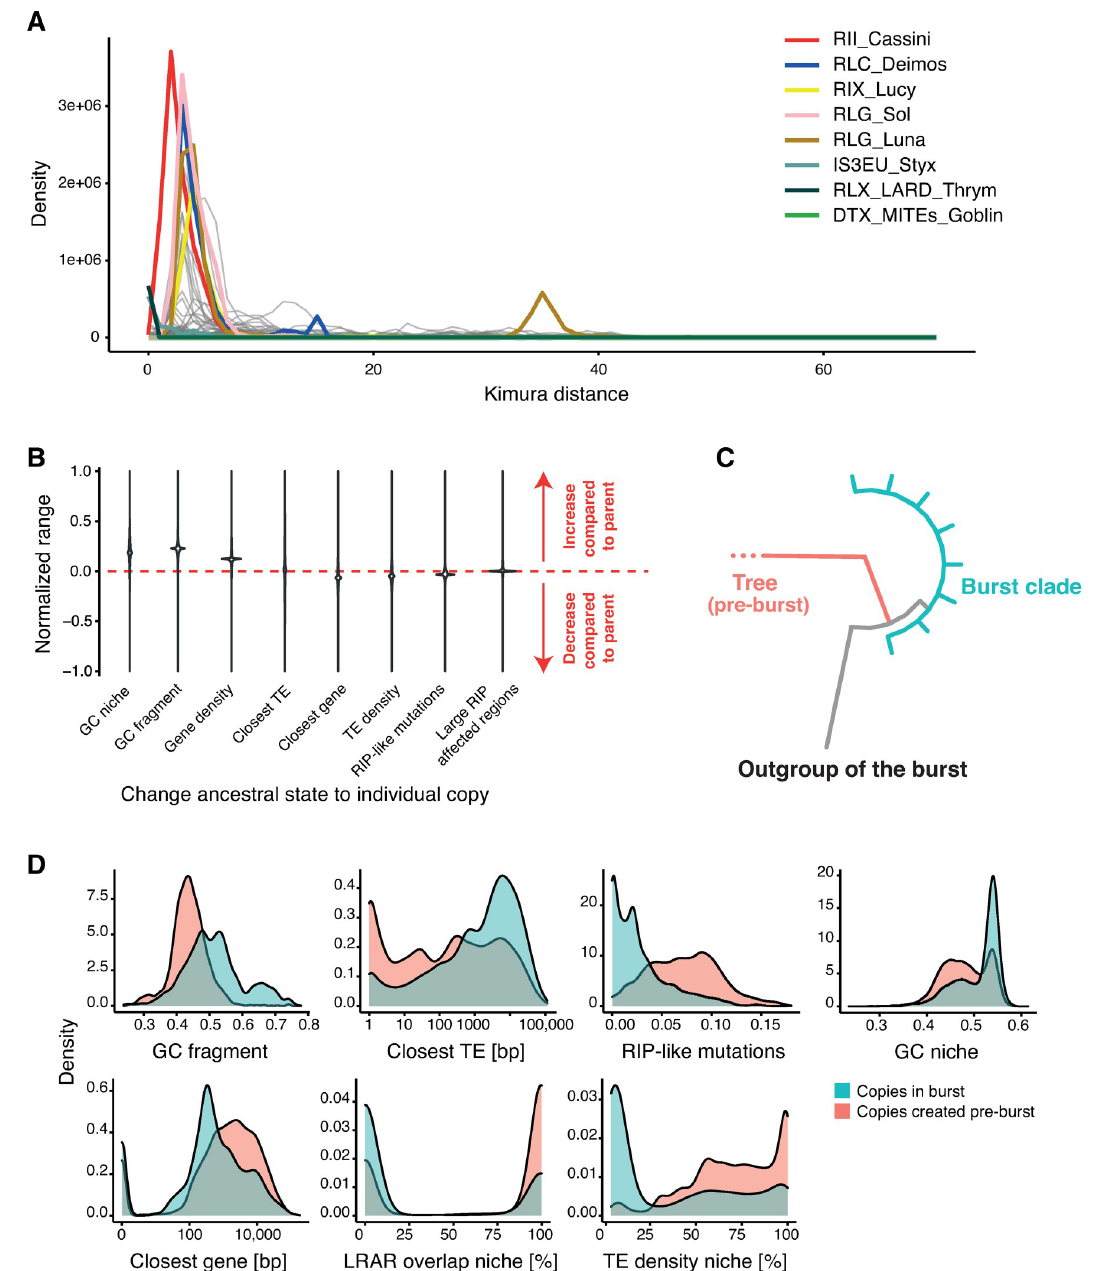
Fig 5. Genomic origin and features of TE transposition bursts: (A) Repeat landscape of the TE families with the highest copy numbers. Colors indicate the highest copy numbers (RII_Cassini, RLC_Deimos, RLG_Sol, RLG_Luna), TEs with multiple bursts (RLC_Deimos, RIX_Lucy and RLG_Luna) or very recent burst (Styx, Thrym). DTX_MITEs_Goblin is included but shows no apparent activity. (B) Normalized range of characteristics of TE copies and their genomic niche compared between the estimated ancestral states and derived copies. A positive value indicates that metrics increased compared to the ancestor sequence, and a negative value indicates a decrease. (C) Scheme of the definition of burst and burst outgroups based on phylogenetic trees of TE families. Green indicates the copies of a burst with low terminal branch lengths and the red outgroup indicates the closest related sister branch of a burst. (D) Distribution of niche and TE copy characteristics of copies belonging to a burst clade (blue) compared to all other copies